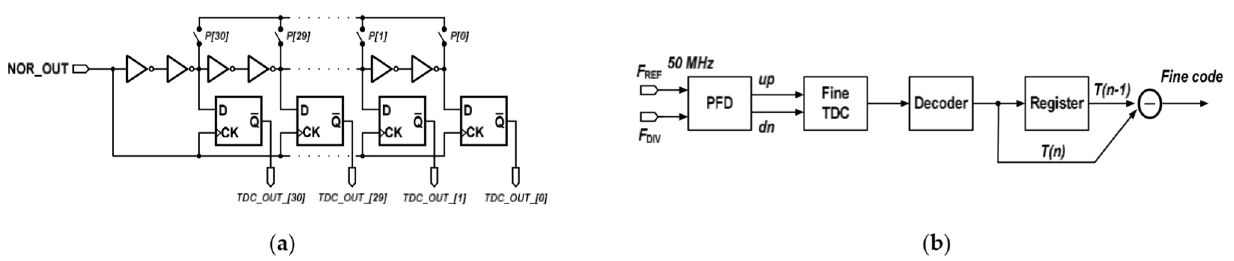
Figure 3. The proposed ( a ) frequency phase detector circuit; and ( b ) frequency detector structure.